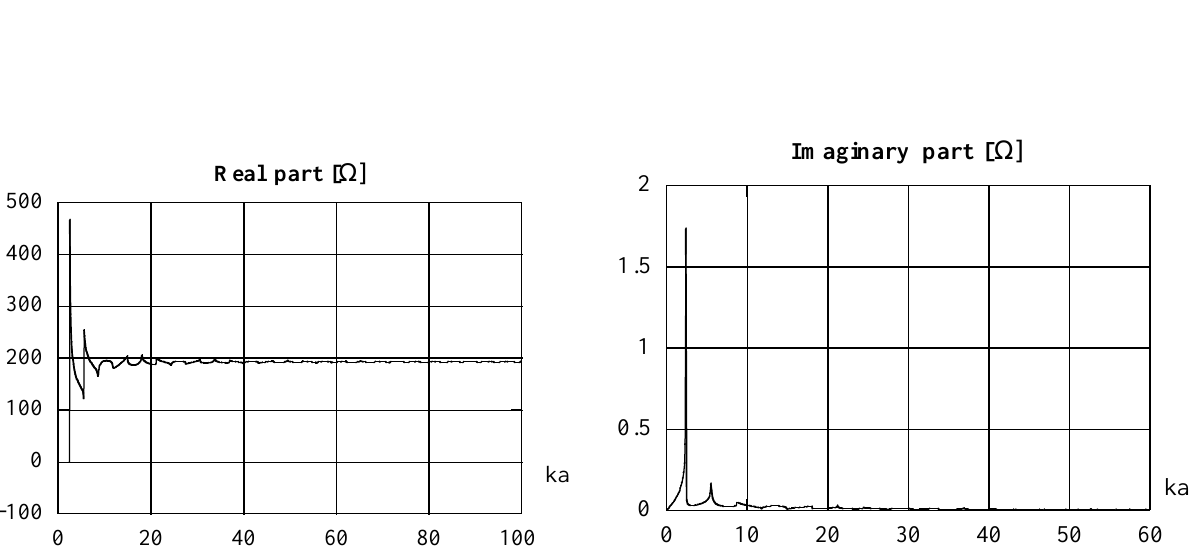
FIG. 17. Real and imaginary parts of the longitudinal coupling impedance in the case (cid:119) (cid:173) (cid:49) (cid:121) (cid:53) and b (cid:173) (cid:49) .